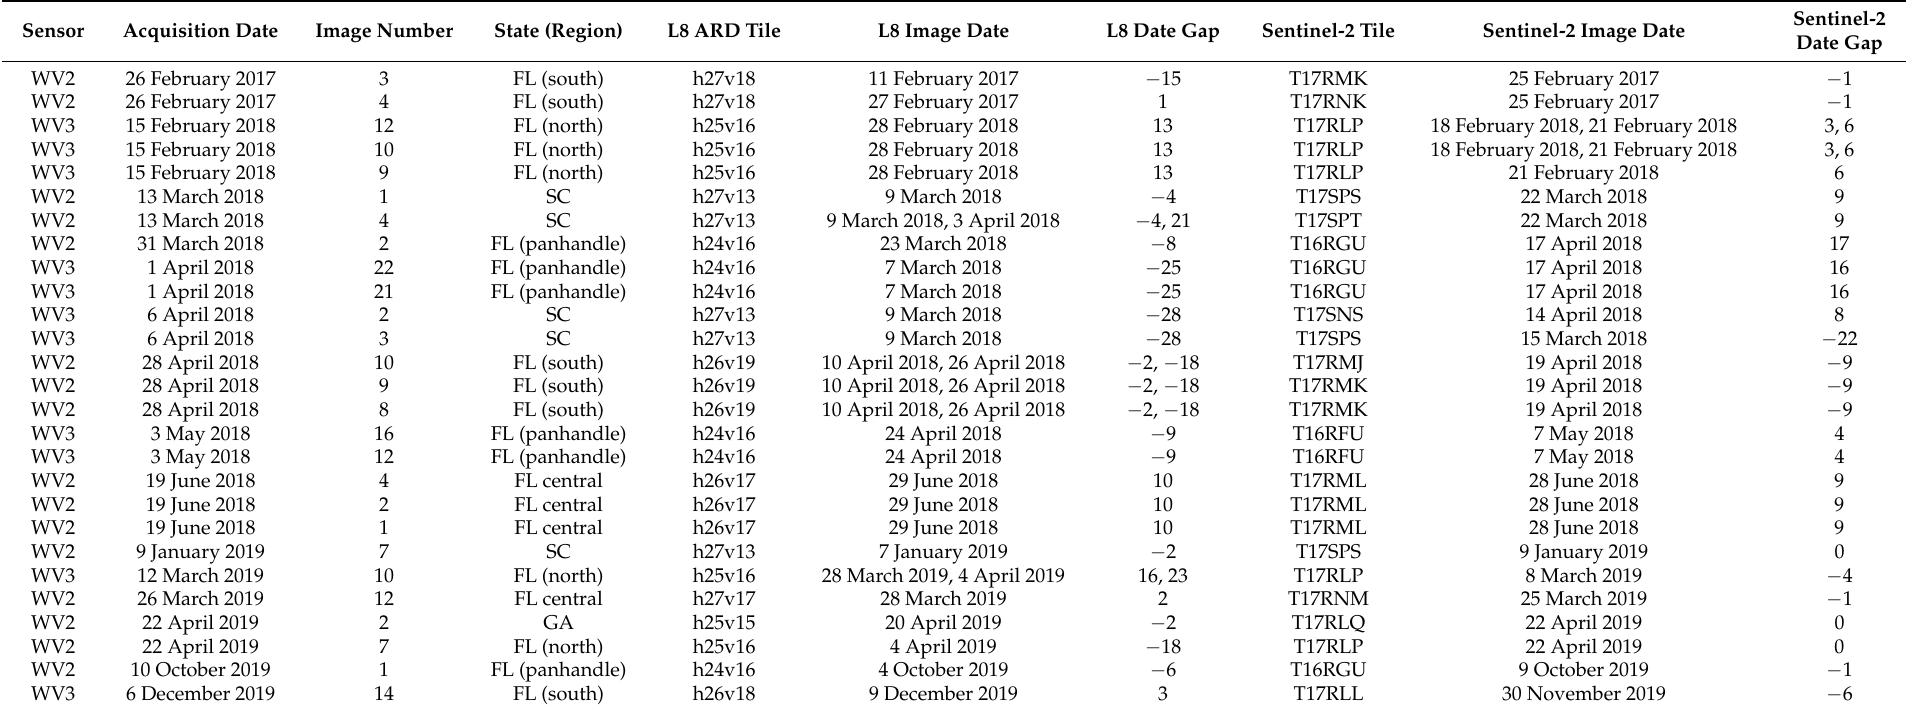
Table A2. Worldview-2 (WV2) and Worldview-3 (WV3) images used for validation. ARD = Analysis Ready Data, h = horizontal, v = vertical, FL = Florida, SC = South Carolina, GA = Georgia, L8 =